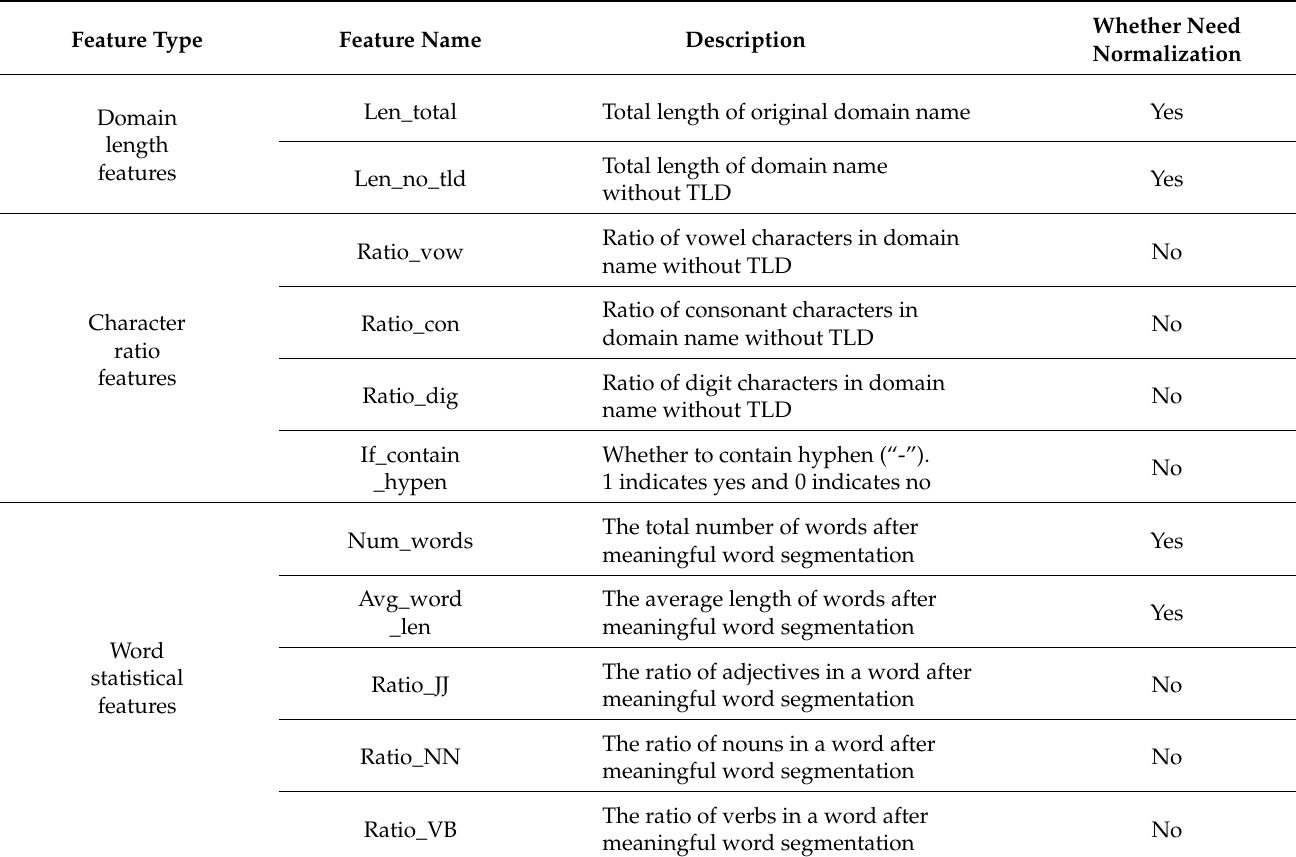
Table 1. Summary of statistical